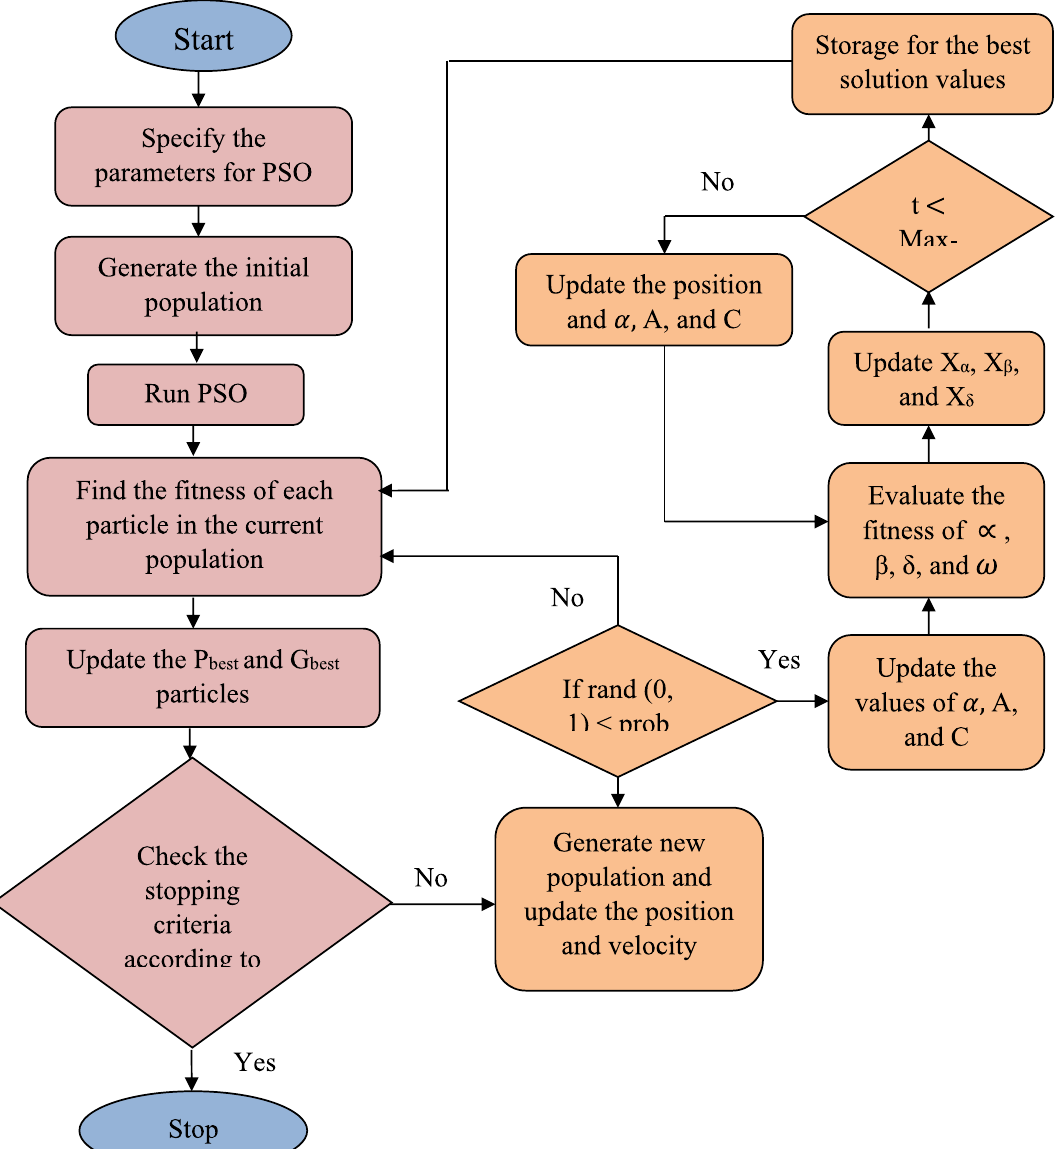
Fig. 3 Flowchart of the PSO–GWO